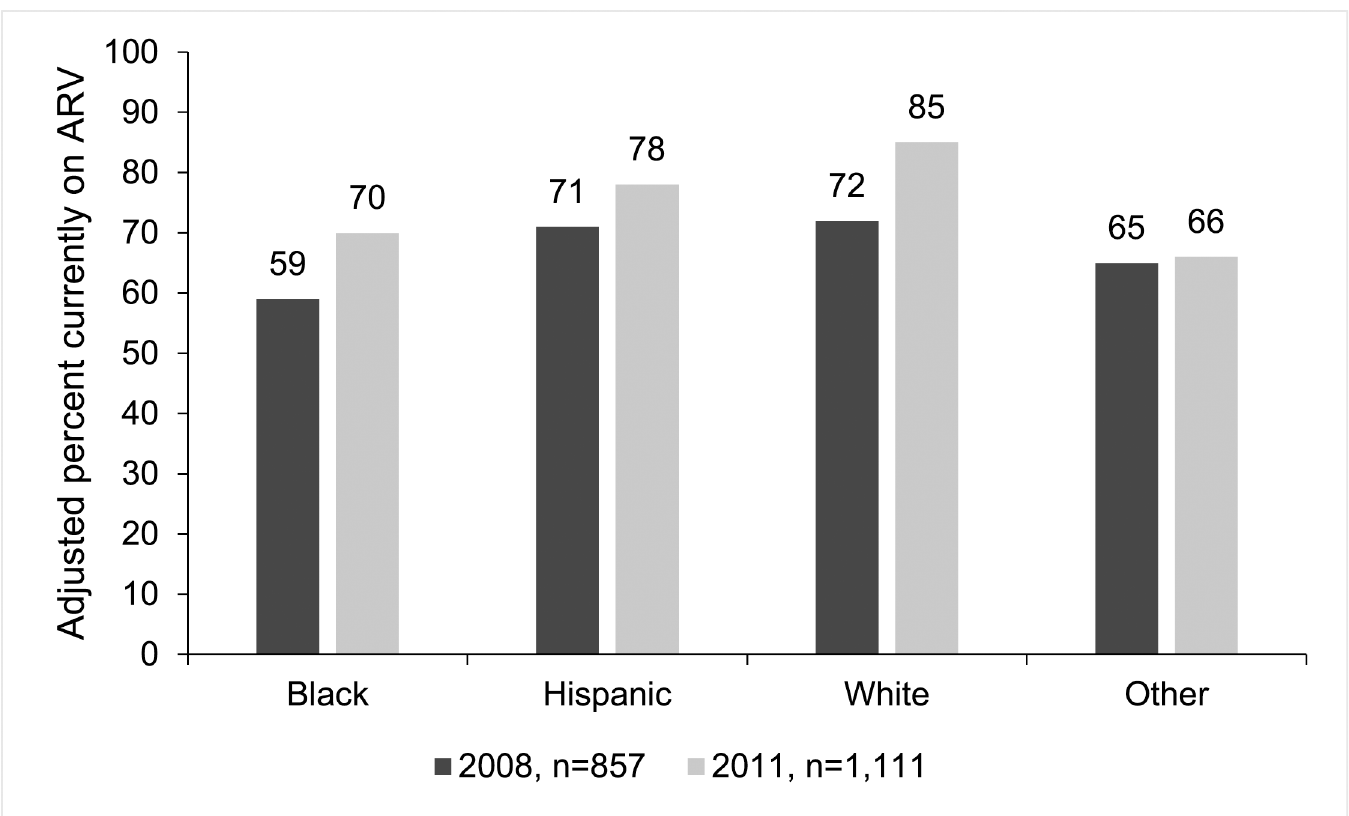
Fig 1. Adjusted prevalence a of current ARV treatment by race/ethnicity among MSM — NHBS, 2008 and 2011. Adjusted prevalences from a model adjusted for year, current age, annual household income, current insurance, venue type where recruitment occurred, and city (random effect) show that the percent of blacks currently on antiretroviral therapy is significantly less than the percent of whites currently on antiretroviral therapy in both years. a Adjusted prevalence estimated from the following model: current ARV = α + β 1 * race + β 2 * age + β 3 * current insurance + β 4 * income + β 5 * venue type + β 6 * year + β combined 2008, 2011 data comparing whites to blacks was 1.09 (CI: 1.02 – 1.16); b Hispanics can be of any race; c Includes MSM reporting American Indian or Alaska Native, Asian, Native Hawaiian or Pacific Islander, other race, or multiple races.